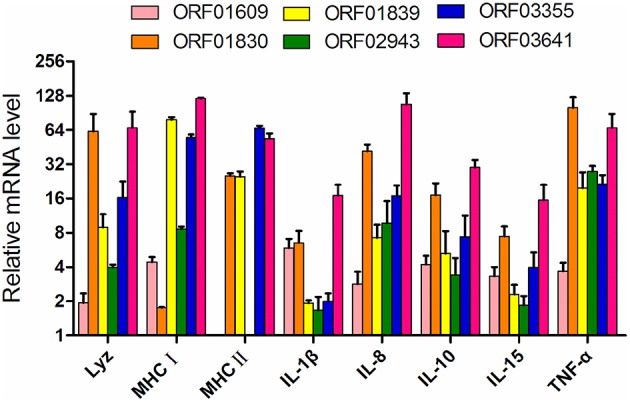
Expression of immune-related genes in zebrafish immunized with recombinant proteins as compared to controls treated with BSA, as quantified by qPCR. Internal organs were collected before the A. hydrophila LP-2 challenge.